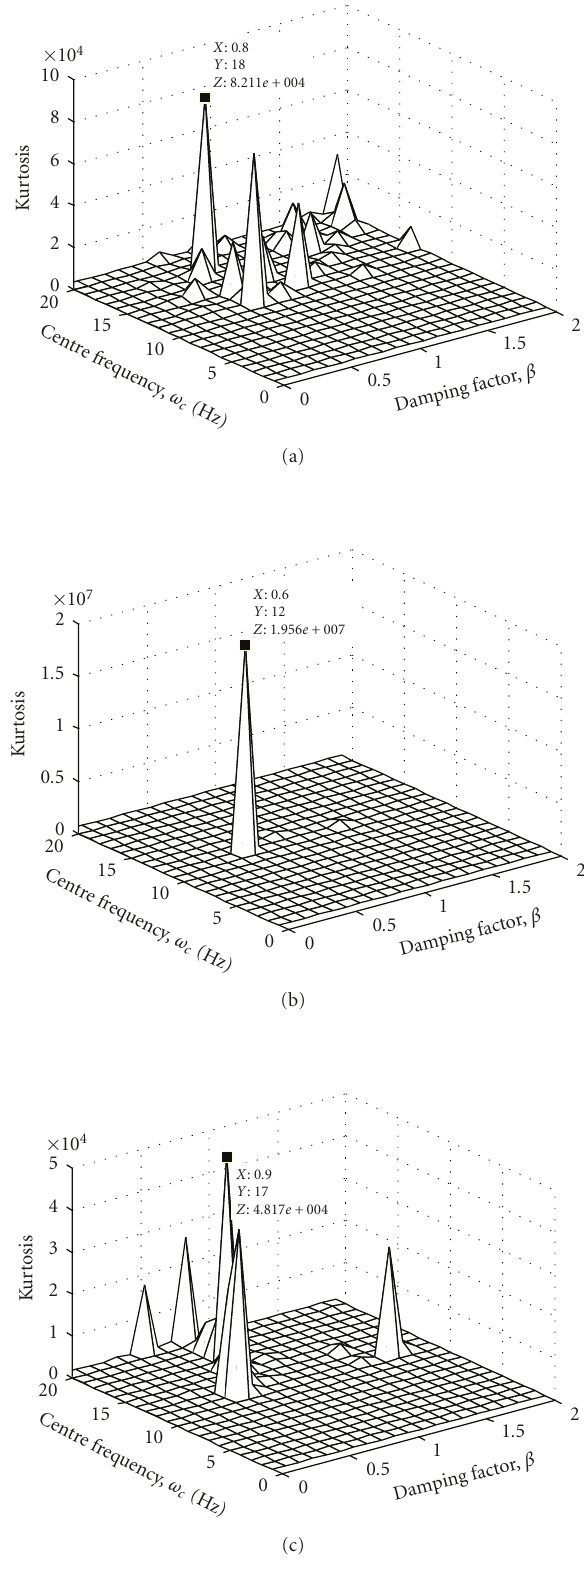
Figure 5: The optimal values for Laplace wavelet parameters based on maximum kurtosis for (a) simulated outer-race fault, (b) the measured outer-race fault, (c) the CWRU vibration